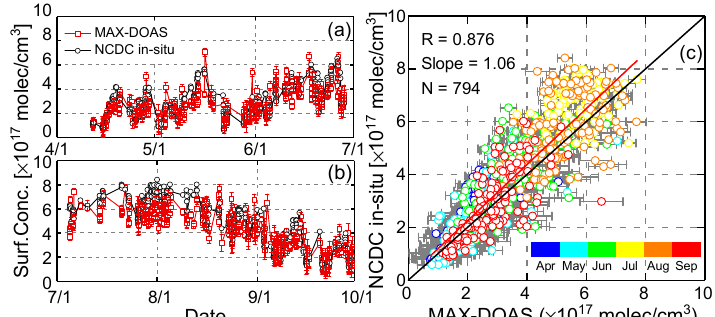
Figure 6. Hourly averaged water vapor surface concentrations retrieved from MAX-DOAS, compared with NCDC in-situ measurements. The variation of water vapor surface concentration from MAX-DOAS and NCDC in two time series: ( a ) 12 April–30 June 2018; ( b ) 1 July–30 September 2018. Panel ( c ) displays the correlations between them. Colors represent the months of the observation period.